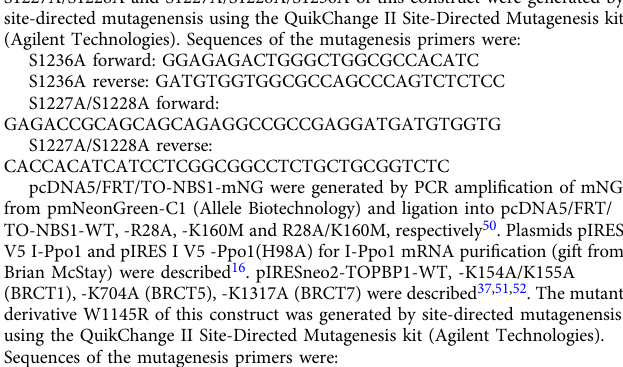
Fig. 6 A conserved TOPBP1 phospho-interaction motif in Treacle. a HA-immunoprecipitations from 293FT cells transfected with the indicated HA-tagged Treacle variants. b TOPBP1 localization 2 h after I-Ppo1 transfection in GFP-Treacle-expressing cell lines after treatment with control siRNA (left panel) and Treacle siRNA (right panel). c Quanti fi cation of the experiment in b , mock: siCtrl ( n = 301) versus siTreacle ( n = 290), WT: siCtrl ( n = 226) versus siTreacle ( n = 242), S1236A: siCtrl ( n = 75) versus siTreacle ( n = 79), S1227A/S1228A: siCtrl ( n = 169) versus siTreacle ( n = 177) and S1227A/S1228A/ S1236A: siCtrl ( n = 77) versus siTreacle ( n = 69) cells. d Quanti fi cation of nucleolar EU incorporation after I-Ppo1 transfection in GFP-Treacle-expressing cell lines after treatment with control siRNA and Treacle siRNA. WT: siCtrl ( n = 216) versus siTreacle ( n = 200), S1236A: siCtrl ( n = 224) versus siTreacle ( n = 224), S1227A/S1228A: siCtrl ( n = 222) versus siTreacle ( n = 227) and S1227A/S1228A/S1236A: siCtrl ( n = 229) versus siTreacle ( n = 232) cells. c , d Statistical signi fi cance was calculated using a one-way analysis of variance and Sidak ’ s multiple comparison test. Bars represent mean ± S.D. All scale bars = 10 µ m. Source data are provided as a Source Data